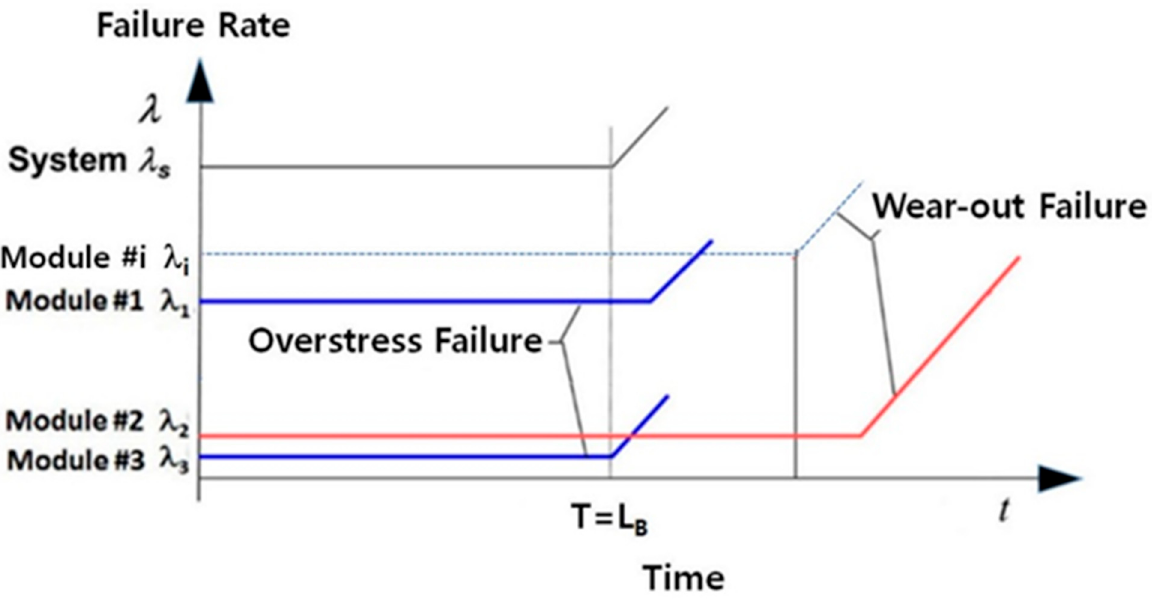
Figure 2. A multimodule system life is resolved by the newly conceived module.